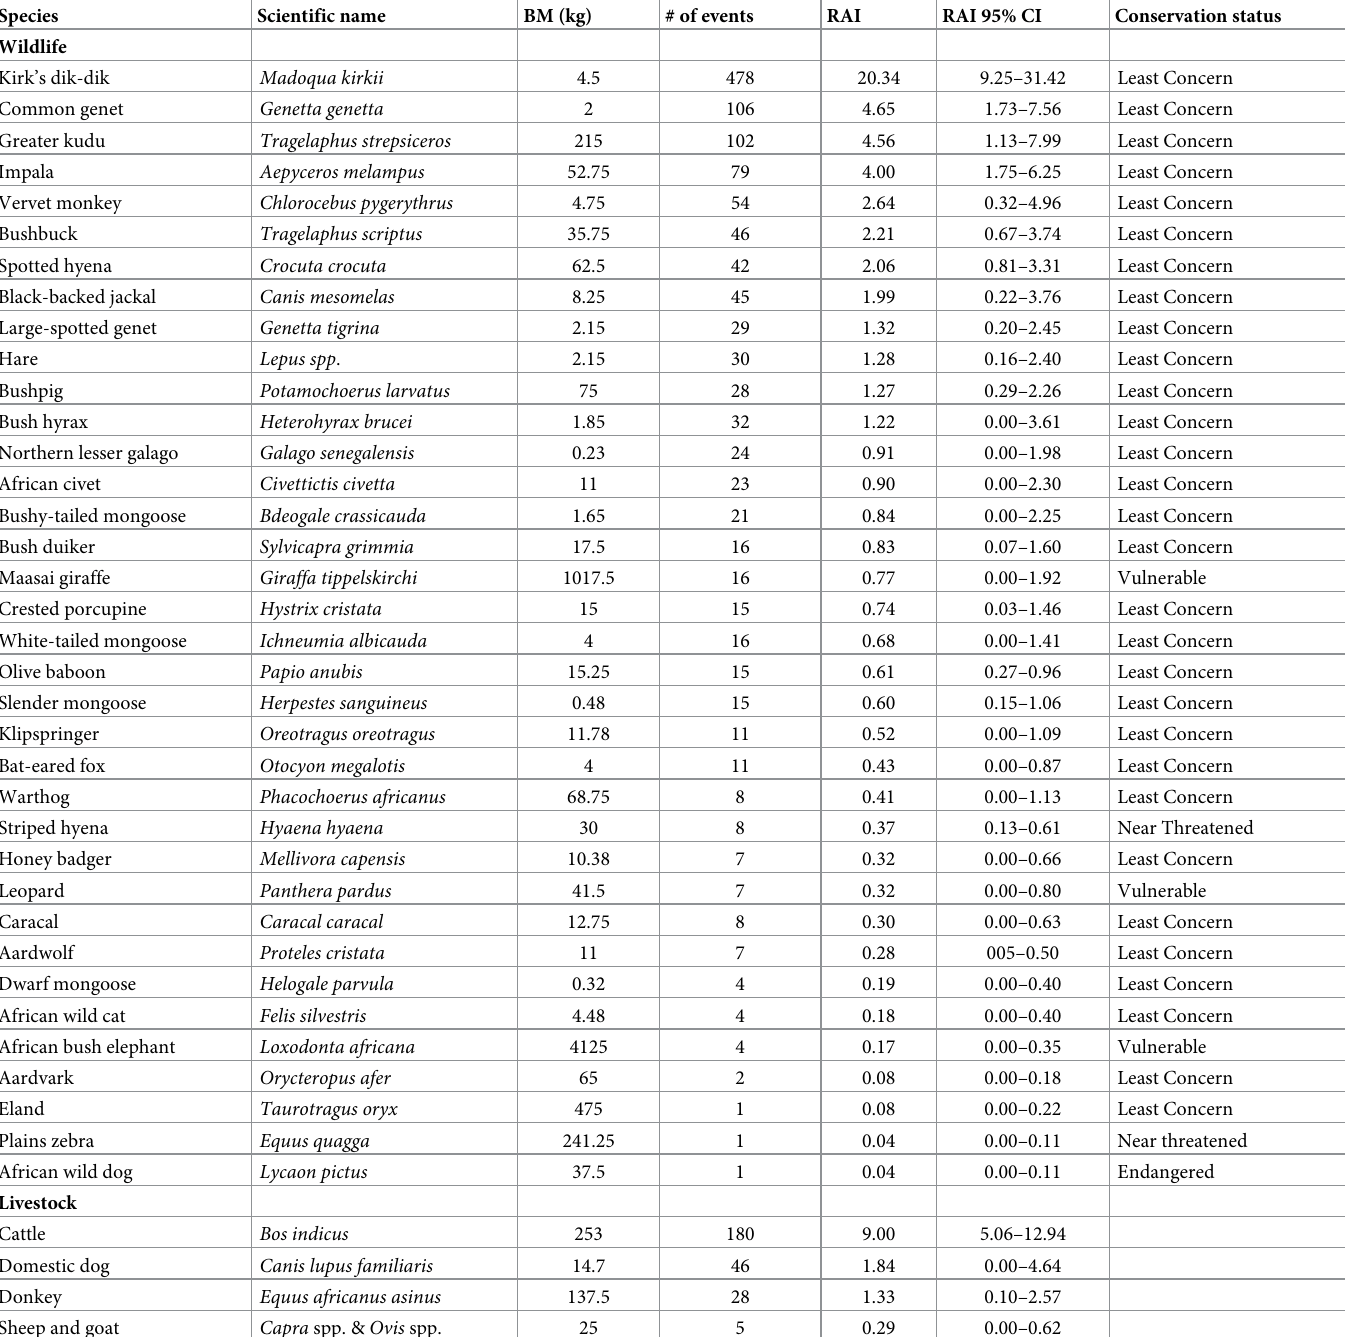
Table 1. Mammal species (listed in descending order of relative abundance) detected during a camera trap survey conducted in Tli’ika, Lake Eyasi region, northern Tanzania in 2018.